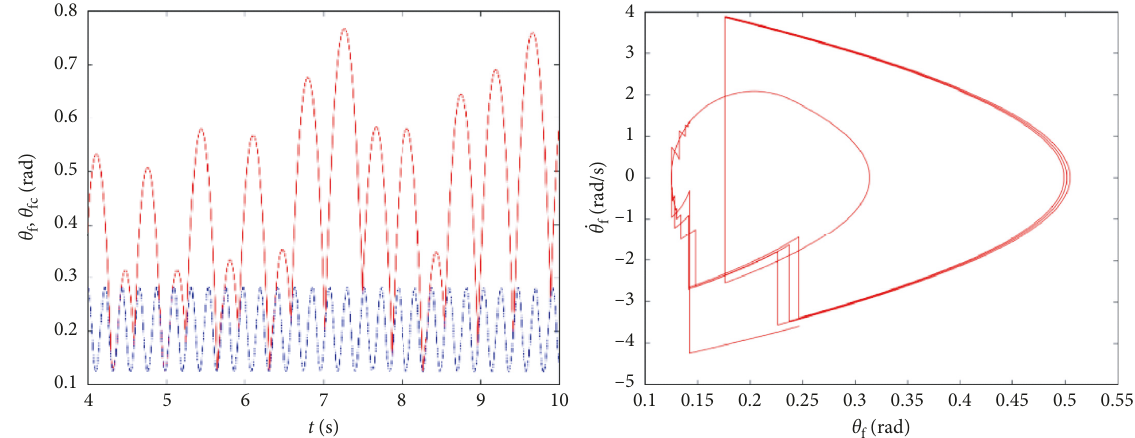
Figure 9: Chaotic response when l